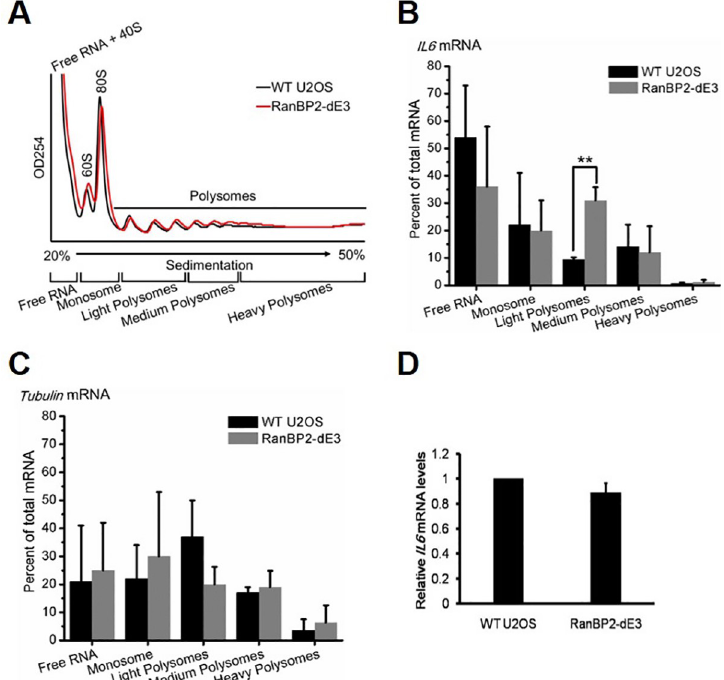
Fig 3. The SUMO E3-ligase domain of RanBP2 is required for the translational repression of IL6 mRNA. Unmodified and RanBP2-dE3 U2OS cells were transfected with an intron-containing IL6-HA construct ( IL6-1i-HA ). 24 h post-transfection, cells were lysed and fractionated by centrifugation over a sucrose gradient (A-C) or directly analyzed by RT-qPCR (D). (A) OD254 trace of the sucrose gradients to determine the distribution of monosomes and polysomes. RT-qPCR of IL6 (B) and α -tubulin (C) mRNA were normalized against luciferase mRNA that was spiked into each fraction to control for RNA recovery. Note the significant increase in IL6 mRNA in the polysome fraction in RanBP2-dE3 cells. (D) IL6-HA and α -tubulin mRNA levels were measured by RT-qPCR. The IL6-HA / tubulin ratio was normalized to unmodified U2OS cells and each bar representing the average of three independent experiments ± SEM. �� P = 0.001–0.01 (Student’s t -test). HEK293 cell line had versions of the RanBP2 gene with a 1 bp deletion (f1) and with a 123 bp deletion (f2) (S5E and S5F Fig). From the cDNA amplification and sequencing we could detect RanBP2 mRNA with the 1 bp deletion from copy f1 (despite the fact that it should trigger non- sense-mediated decay) and mRNA missing exon 21, which again we presume was made from the f2 copy of the gene (Figs 4I and 4J and S3E). As is the case with the mutant U2OS and HAP1 cell lines, both mutant HEK293 cell lines had elevated levels of IL6-HA protein and a drastic reduction in RanGAP1 sumoylation (Fig 4K and 4L).